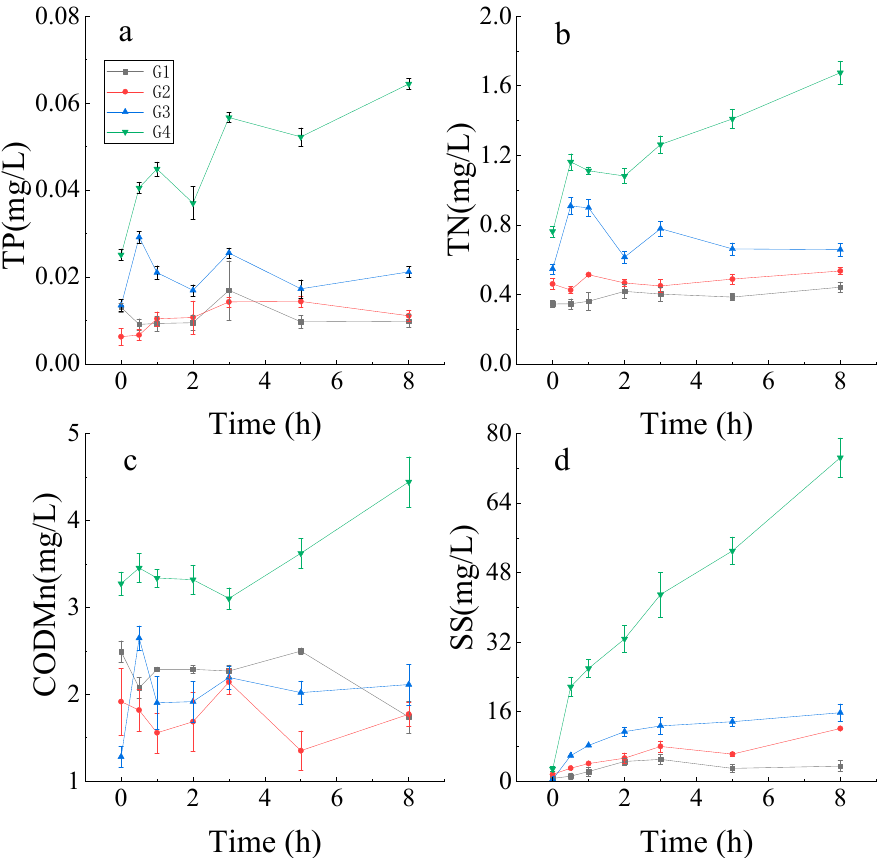
Figure 2. Changes in the average concentration of ( b ) total nitrogen (TN), ( a ) total phosphorus (TP), ( c ) chemical oxygen demand (COD), and ( d ) suspended solids (SS) of overlying water under four working conditions.